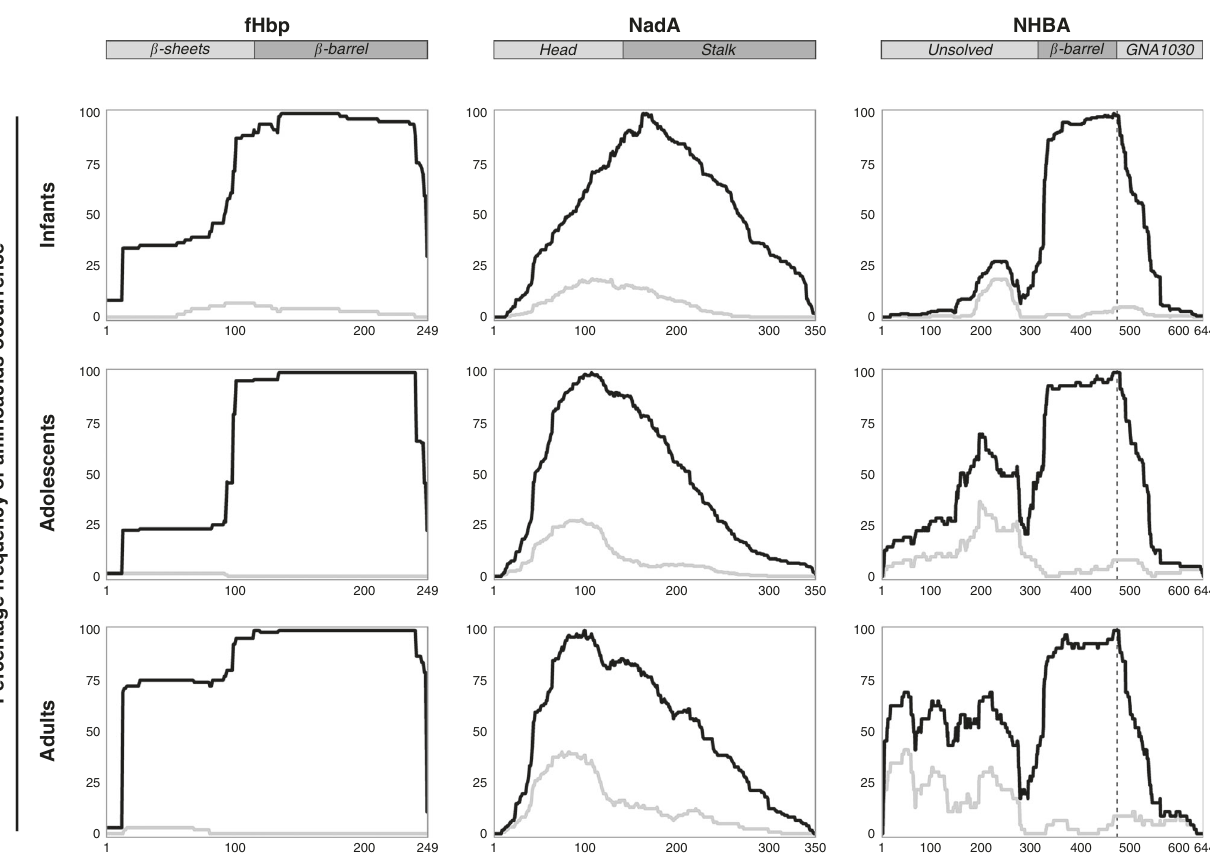
Fig. 1 Phage display selection frequency of aminoacids along antigen primary structures. Sera were analysed as pool by age group (40 infant, 12 adolescent and 29 adult samples). Aminoacid position in the sequence of reference proteins from N-term to C-term is reported on horizontal axis, while vertical axis shows the relative frequency of occurrence for the corresponding aminoacid in the in-frame af fi nity selected fragments. Frequency refers to the total in-frame fragments analysed in each experiment. Light grey curves are produced by considering only short fragments spanning less than 100